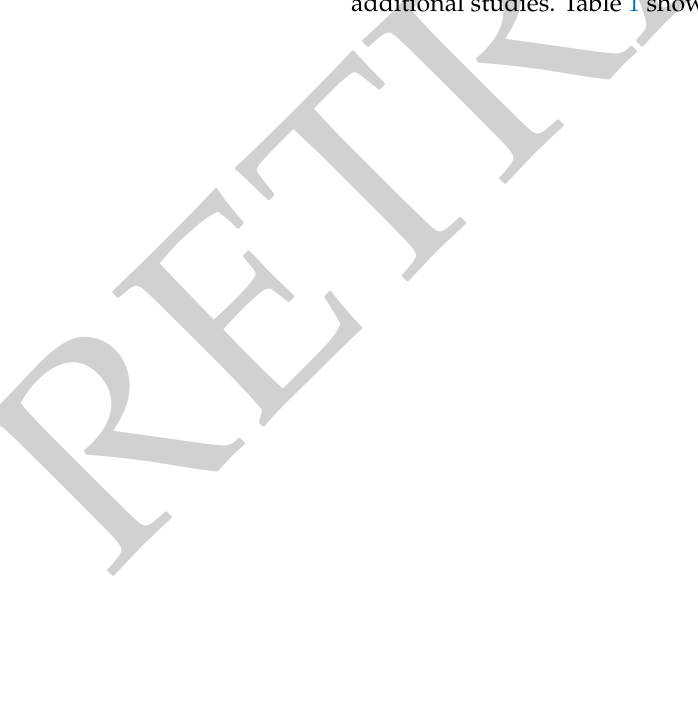
Table 2. Characterization methods used in CFRC/GFRC recycling processes [40].